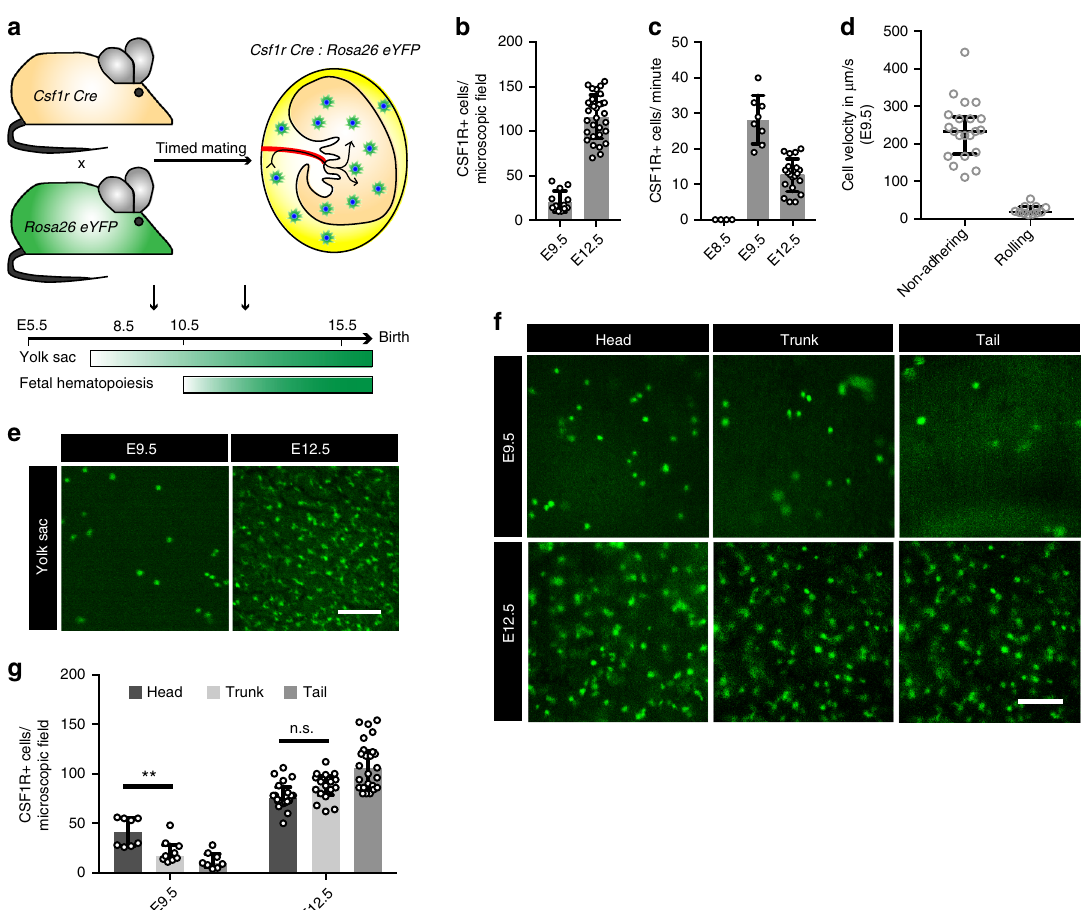
Fig. 5 Traf fi cking kinetics of CSF1R+ cells are similar to pre-macrophages. a Schematic graph for the Csf1r Cre : Rosa26 eYFP mouse model. b , e Fluorescence images of CSF1R YFP+ cells (green) in the YS ( e ) with corresponding quanti fi cations ( b ) of cells per microscopic fi eld at indicated time points; mean ± SD. c Quanti fi cation of intravascular CSF1R+ cells in an average-sized vessel; mean ± SD. d Velocity of intravascular non-adhering ( n = 21) and rolling ( n = 11) CSF1R+ cells in the YS at E9.5; median ± IQR. f , g Fluorescence images of CSF1R YFP+ cells (green) in different embryonic regions ( f ) with corresponding quanti fi cations ( g ) of cells per microscopic fi eld at indicated time points; ** p = 0.0072, n.s. p = 0.0569 (two-tailed Mann – Whitney test); median ± IQR. Scale bars are 100 µ m ( e , f